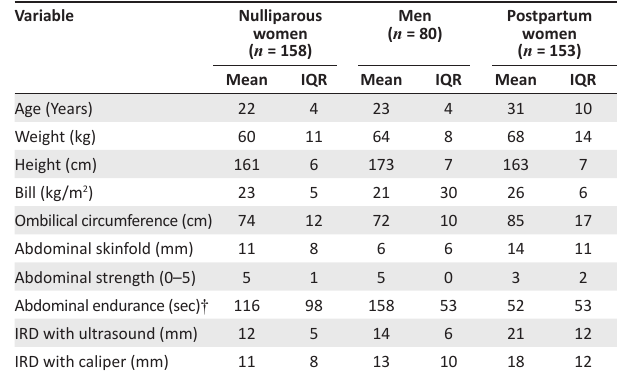
TABLE 1: Characteristics of participants in the three samples of the Beninese population ( n =